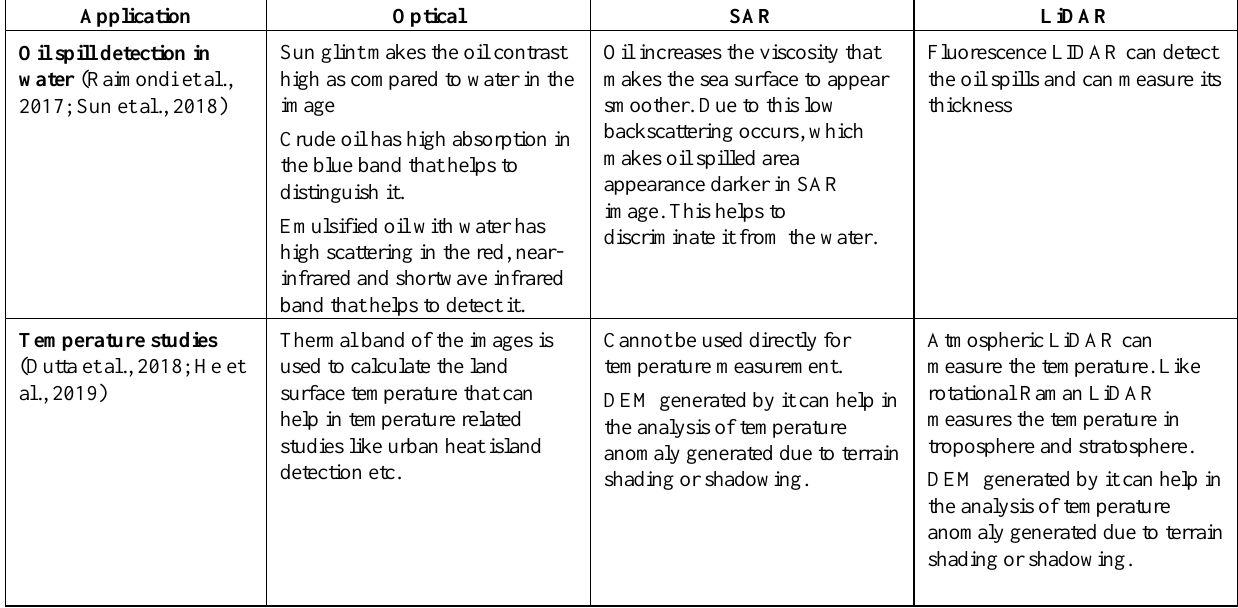
Table 2. Comparison between optical, SAR and LiDAR imaging techniques on the basis of